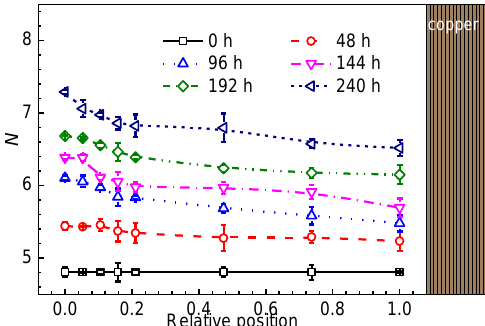
Figure 4. Profile of N for different XLPE samples.